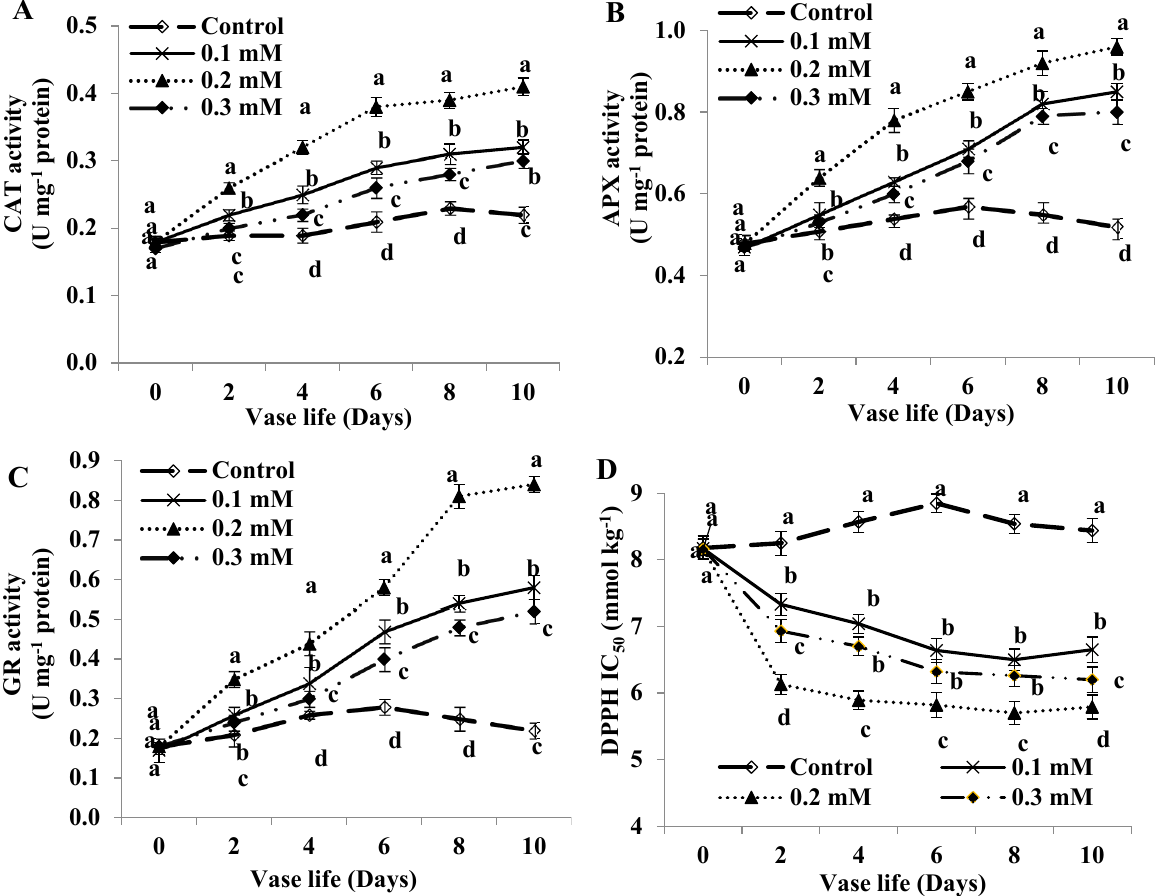
Figure 4. Activity of: ( A ) catalase (CAT); ( B ) Ascorbate peroxidase (APX); ( C ) glutathione reductase (GR) enzyme and ( D ) radical scavenging activity of cut roses treated with melatonin at 0.1, 0.2 and 0.3 mM. Each value is the mean ± SE of two experiments. Values that have different letters are significantly different based on Tukey-Kramer’s multiple range test at p ≤ 0.05.